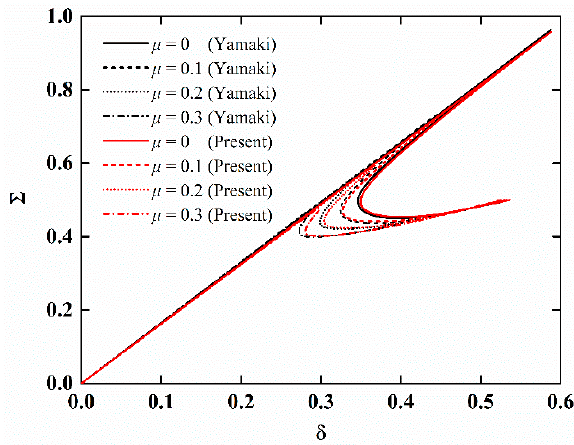
Figure 2. Comparison of load ‐ edge shortening curves of imperfect isotropic cylindrical shells.